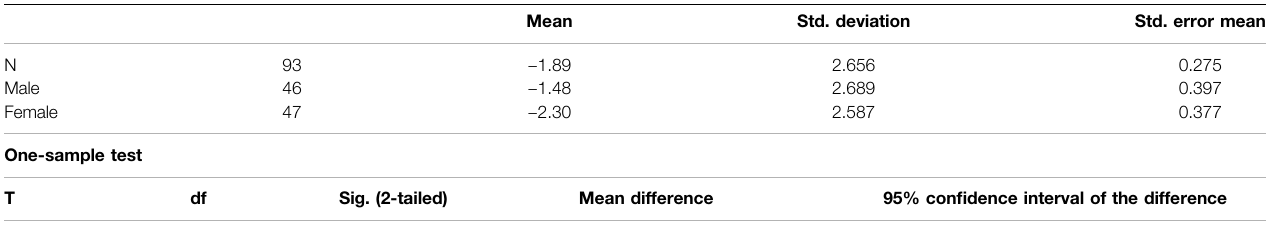
TABLE 3 | SPSS output for “ How to become involved in politics Google. ” Sample statistics for “ How to become involved in politics Google